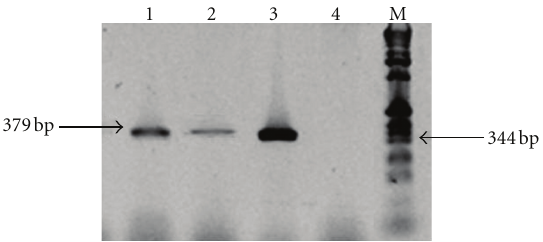
Figure 2: Agarose gel electrophoresis analysis of PCR amplifi- cation of extracted DNA from lobster hepatopancreas. PCR was performed using Primers NHP/F2 and NHP/R2 [9]. Lanes 1 and 2 indicate hepatopancreas from lobsters inoculated with NHPB, Lane 3 positive control NHPB of shrimp hepatopancreas, Lane 4 hepatopancreas from control lobster, Lane M 1kb Ladder DNA marker.